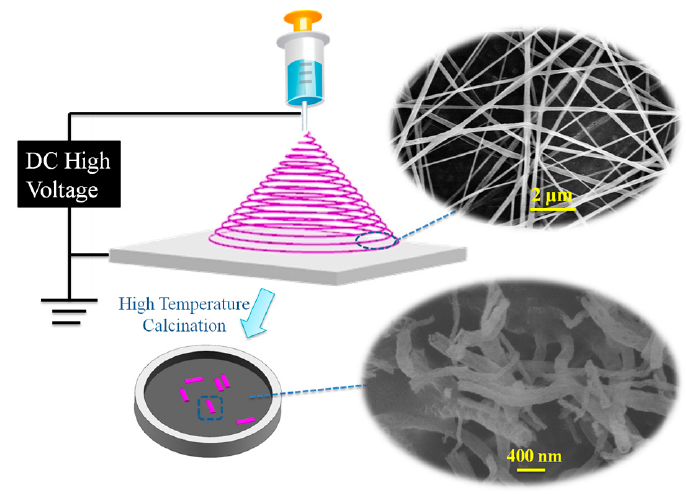
Figure 1. The preparation of Al 2 O 3 fiber and the micro-structure. Figure 2 a is a schematic diagram of the reaction of Al 2 O 3 fiber grafting KH550. After the surface is hydroxylated, it is dehydrated and condensed with the amino group of KH550. The amino group of KH550 is combined with the surface of Al 2 O 3 . The repulsive force between the particle and the parent molecular chain.